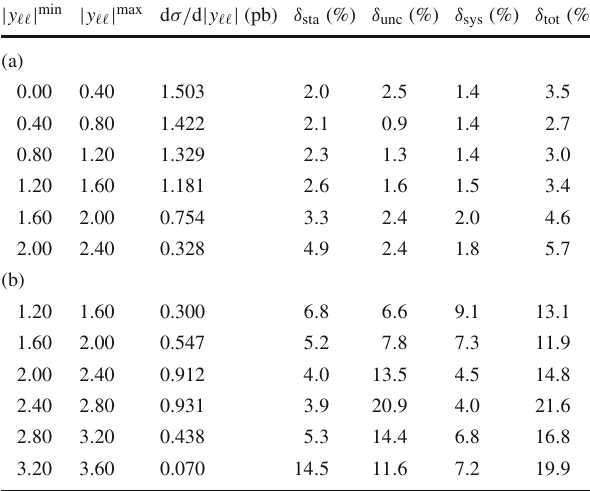
Table 26 Differential cross section for the Z /γ ∗ → e + e − process in the central (a) and forward (b) region with 116 < m (cid:3)(cid:3) < 150 GeV, extrapolatedtothecommonfiducialregion.Therelativestatistical( δ sta ), uncorrelated systematic ( δ unc ), correlated systematic ( δ sys ), and total ( δ tot ) uncertainties are given in percent. The overall 1 . 8% luminosity uncertainty is not